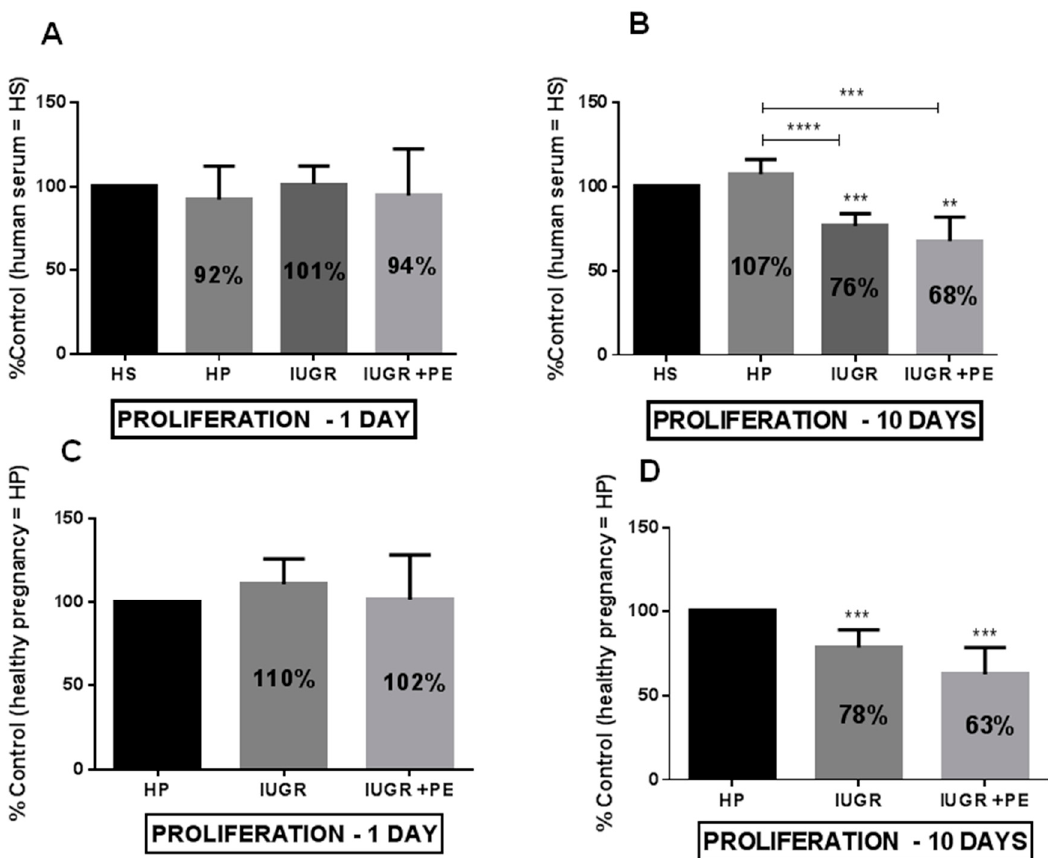
Figure 2. Endothelial cell proliferation ( A ) Endothelial cell proliferation after one day of exposition to medium supplemented with tested sera, expressed as a percent of control which was the human serum taken from non-pregnant women with matched age(HS); ( B ) Endothelial cell proliferation after ten days of exposition to medium supplemented with tested sera, expressed as a percent of control HS ( C ) Endothelial cell proliferation after one day of exposition to medium supplemented with tested sera, expressed as a percent of control which was the human serum taken from healthy pregnant women (HP); ( D ) Endothelial cell proliferation after ten days of exposition to medium supplemented with tested sera, expressed as a percent of control HP. Abbreviations: IUGR—pregnant women with intrauterine growth restriction; IUGR + PE—pregnant woman with both intrauterine growth restriction and preeclampsia. The data were interpreted with repeated measures analysis of variance (one way ANOVA) using a post hoc test for multiple comparisons (Dunn’s or Tukey’s tests). The results are expressed as mean ± standard deviation (SD), derived from 2 independent experiments, and were calculated as a percent of control HS (panel A and B) and control HP (panel C and D). Asterisks represent a significant difference when compared with the representative control cells: * p < 0.05, ** p < 0.01, *** p < 0.001, **** p < 0.0001.